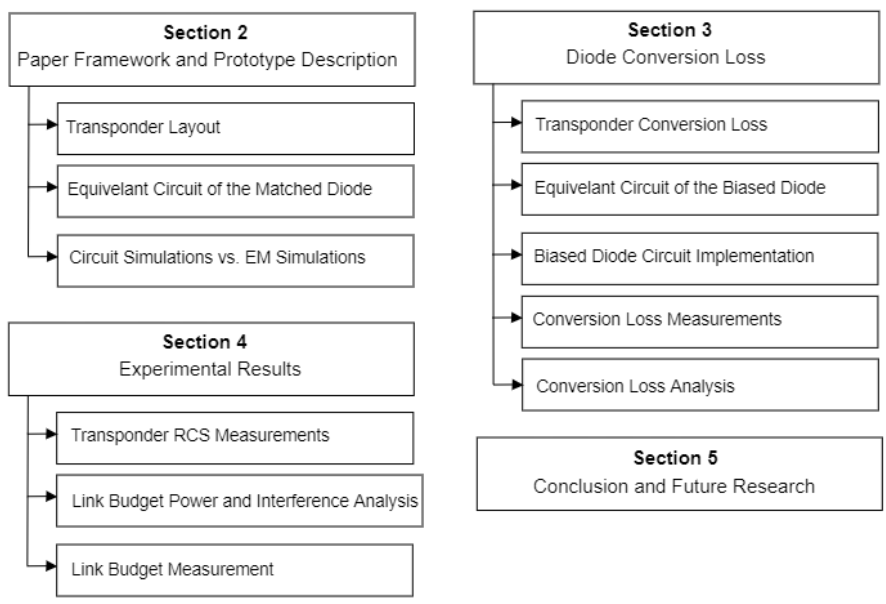
Figure 1. Paper framework.